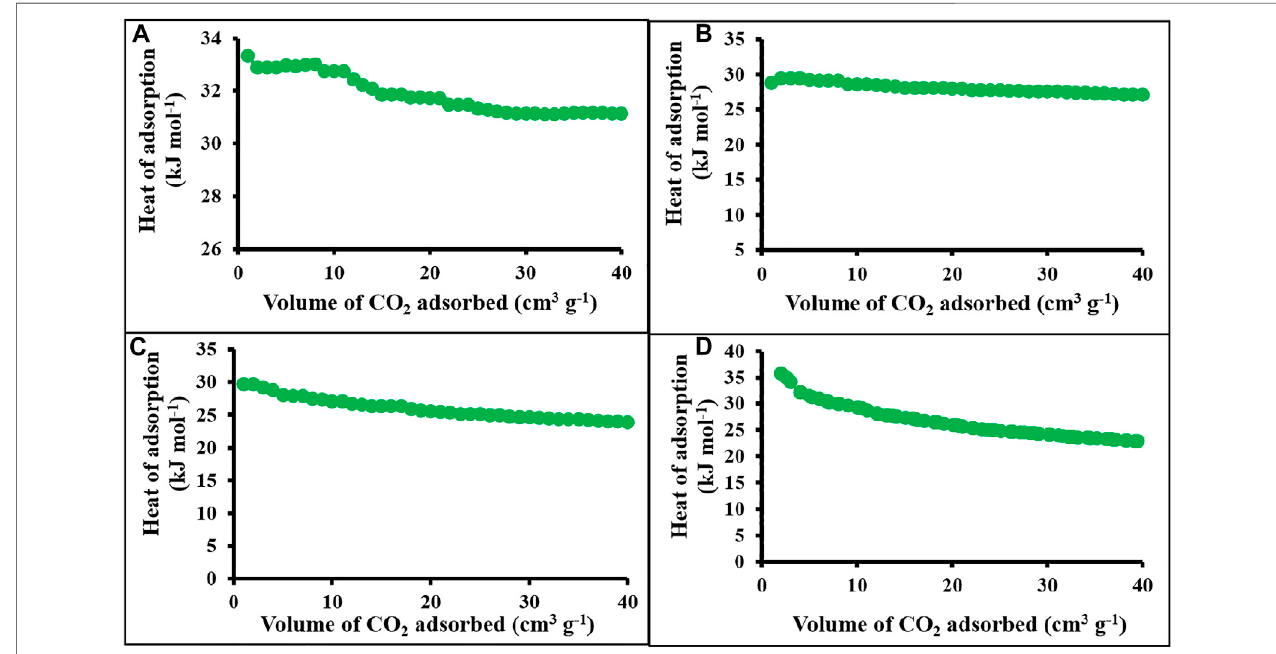
FIGURE 6 | Heat of adsorption plots of (A) p-2CzPN, (B) p-4CzPN, (C) c-2CzPN – KOH, and (D) c-4CzPN – KOH.